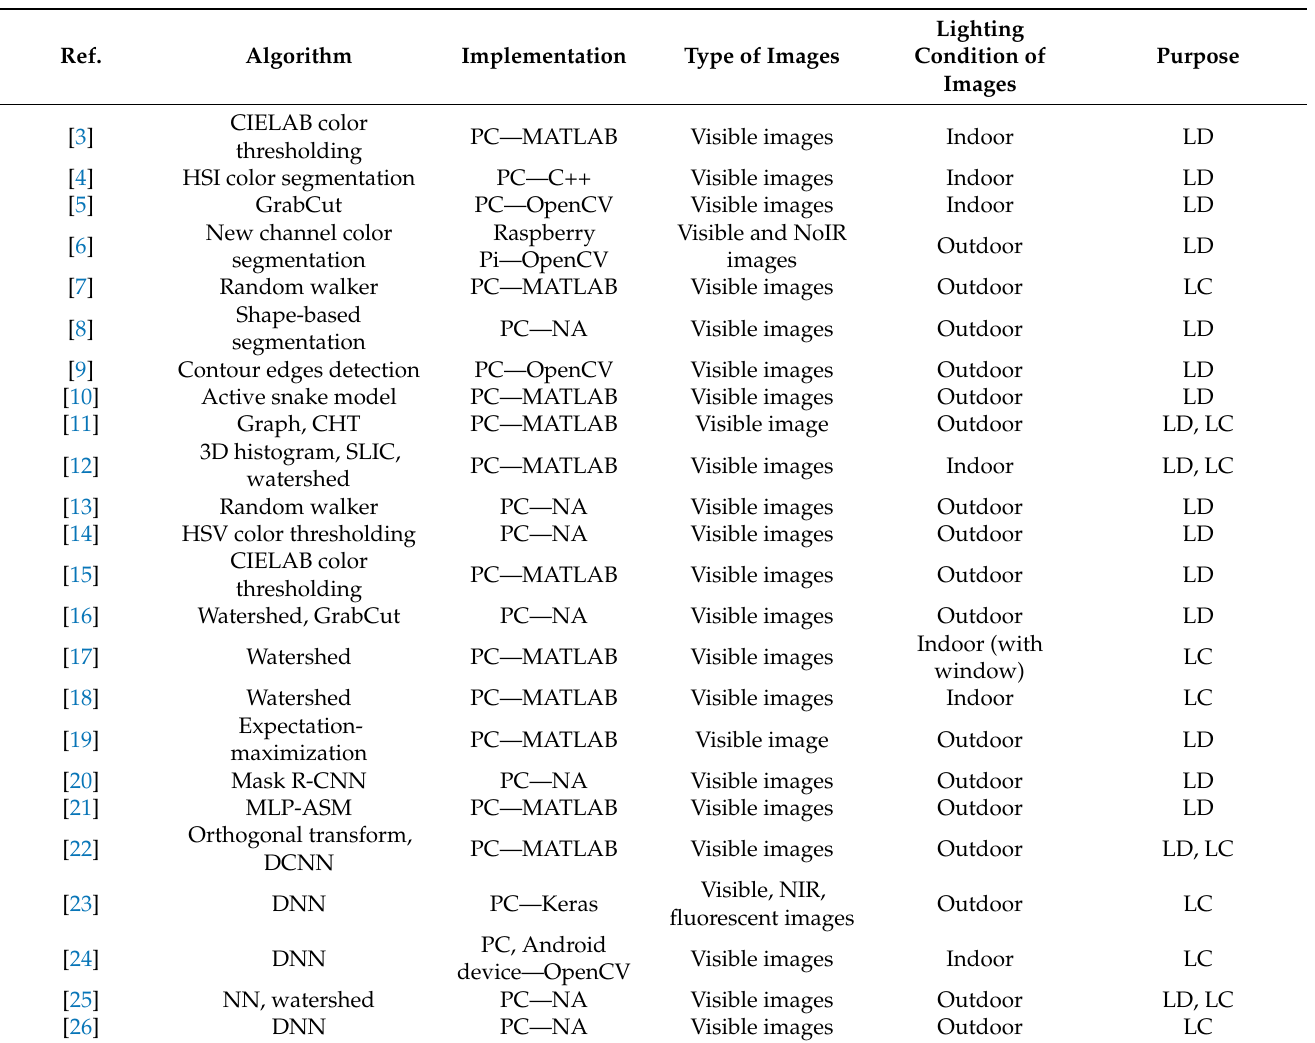
Table 1. Existing leaf detection and counting techniques.